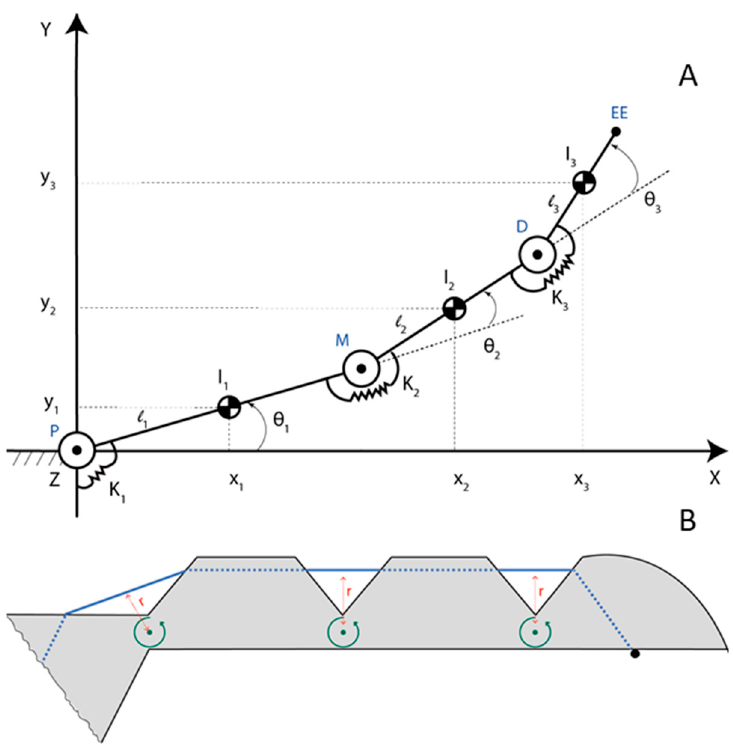
Figure 3. ( A ) Model of the finger. ( B ) Schematic of the finger.